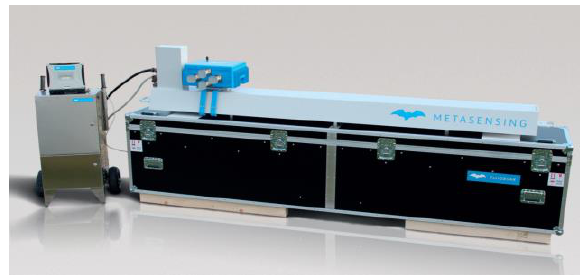
Figure 1. Fast-GBSAR system